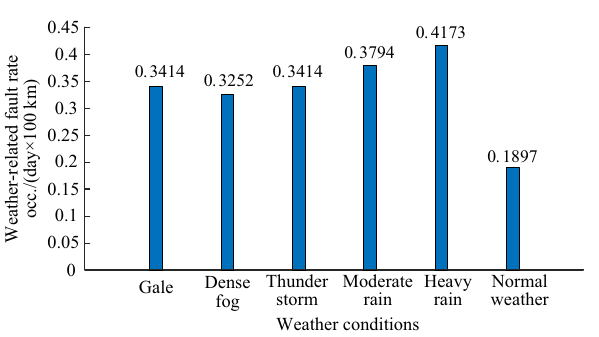
Fig. 4 FRWB under different